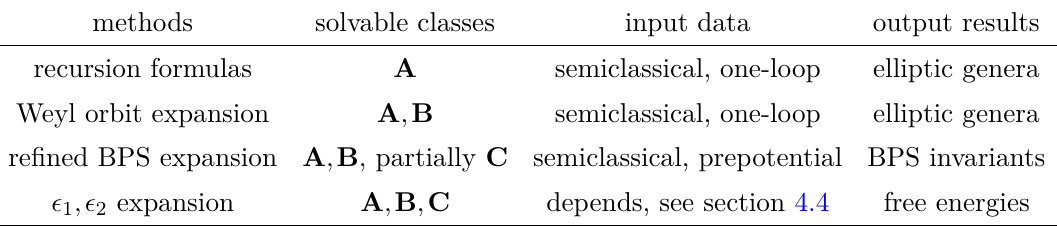
Table 12 . Summary of methods to solve blowup